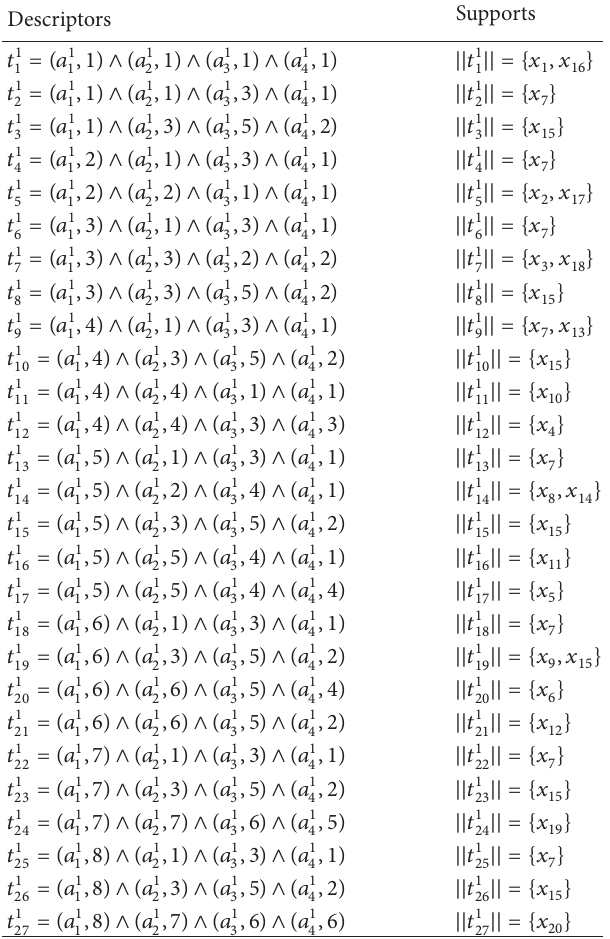
Table 2: Full AT 1 descriptors and their